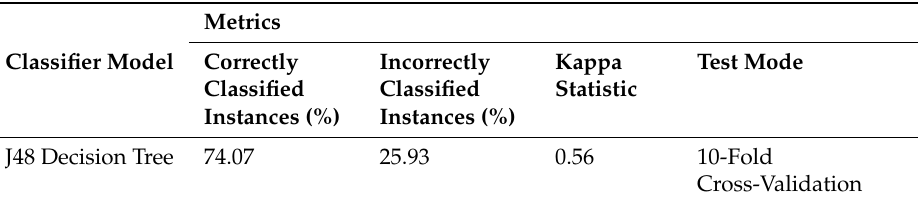
Table 2. Classifier performance (J48 decision tree) for scale class prediction models of the level of the energy-environmental e ffi ciency of biofuel.